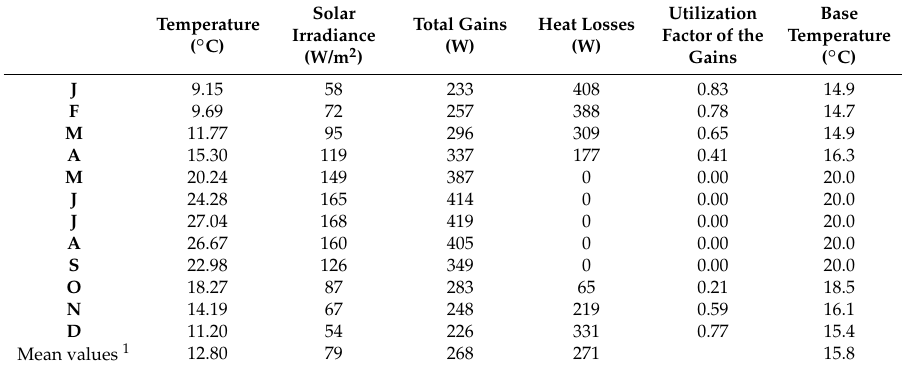
Table 3. Estimation of the duration of the heating period and the respective mean